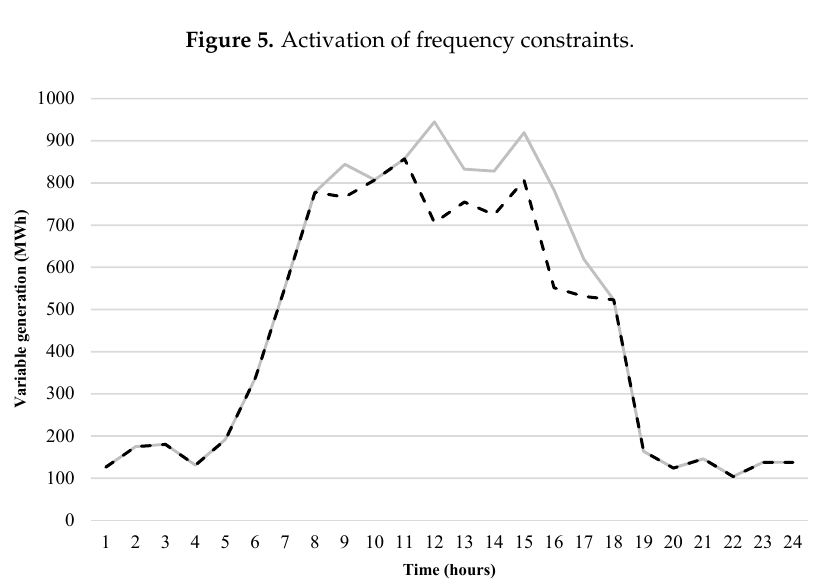
Figure 6. Gray solid line: generation available from VGT. Black dashed line: used generation from VGT.